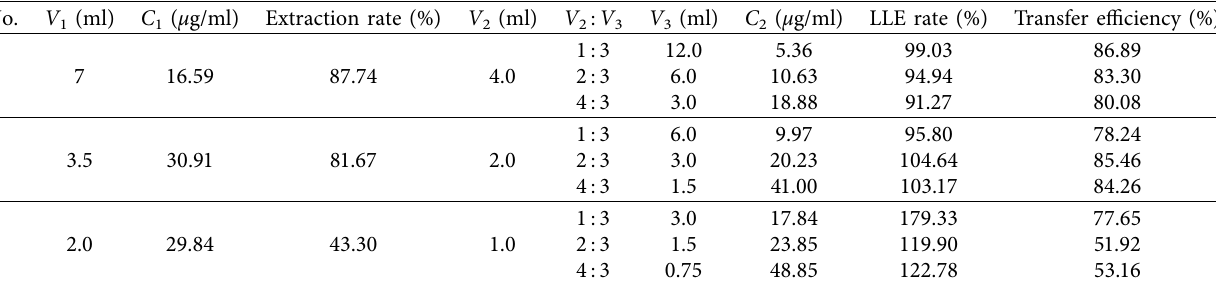
Table 2: The analysis results of the orthogonal experiment.